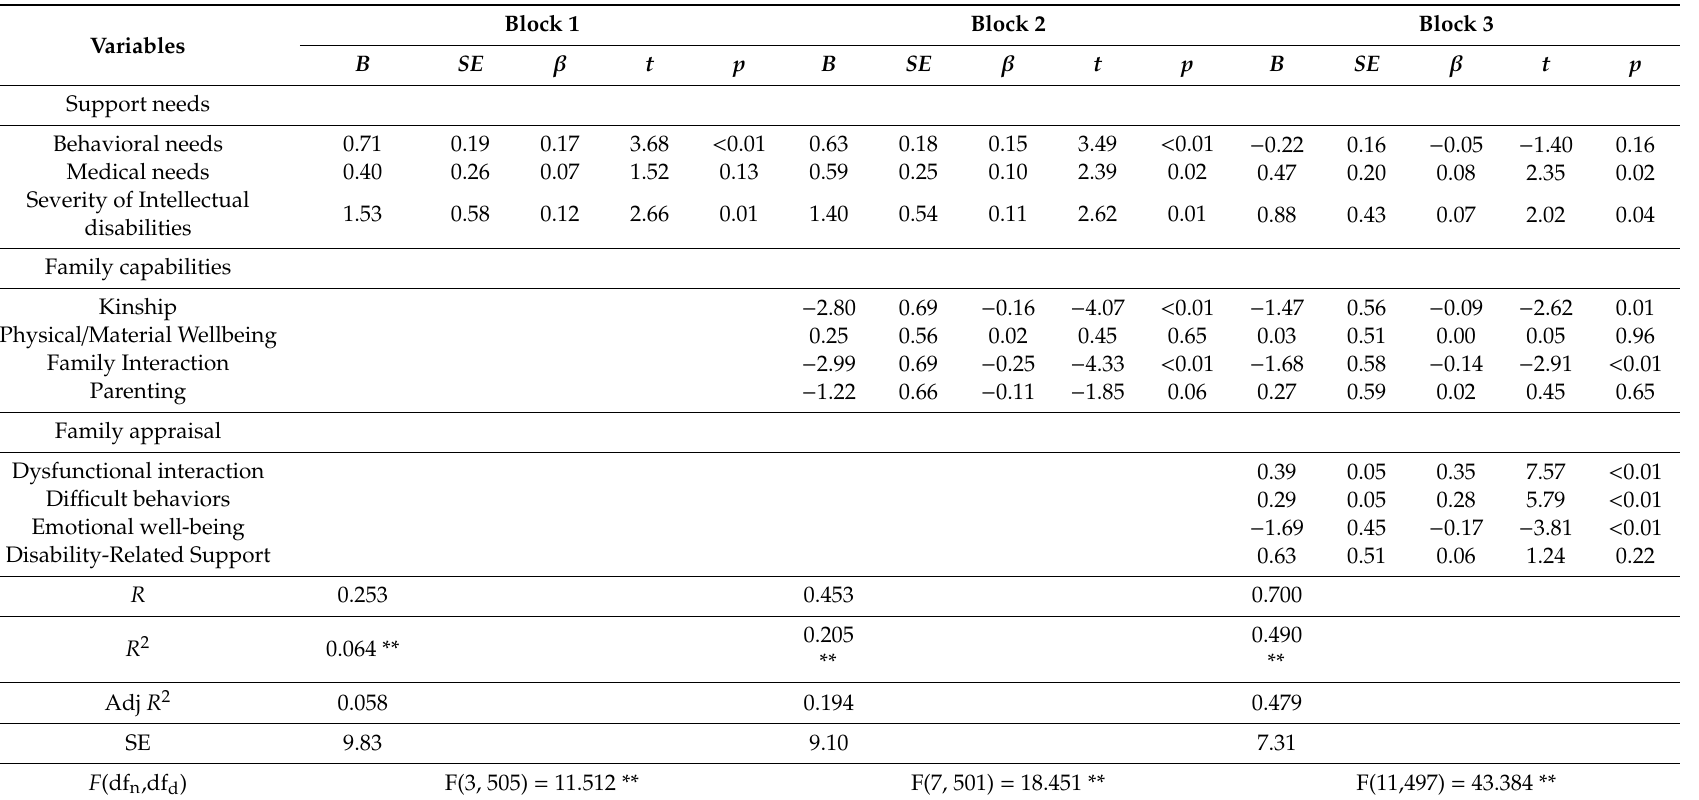
Table 4. Summary of hierarchical regression of Parental